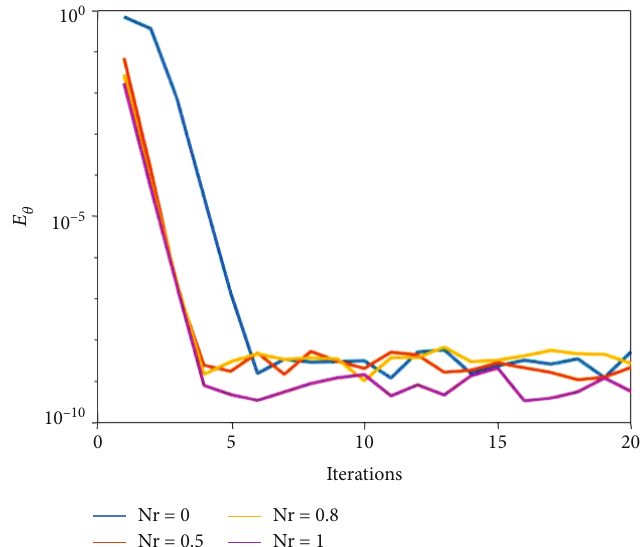
: 8, ξ = 1, N N Df = Bi = Sr = 0 : 5, He b = t = w = 0